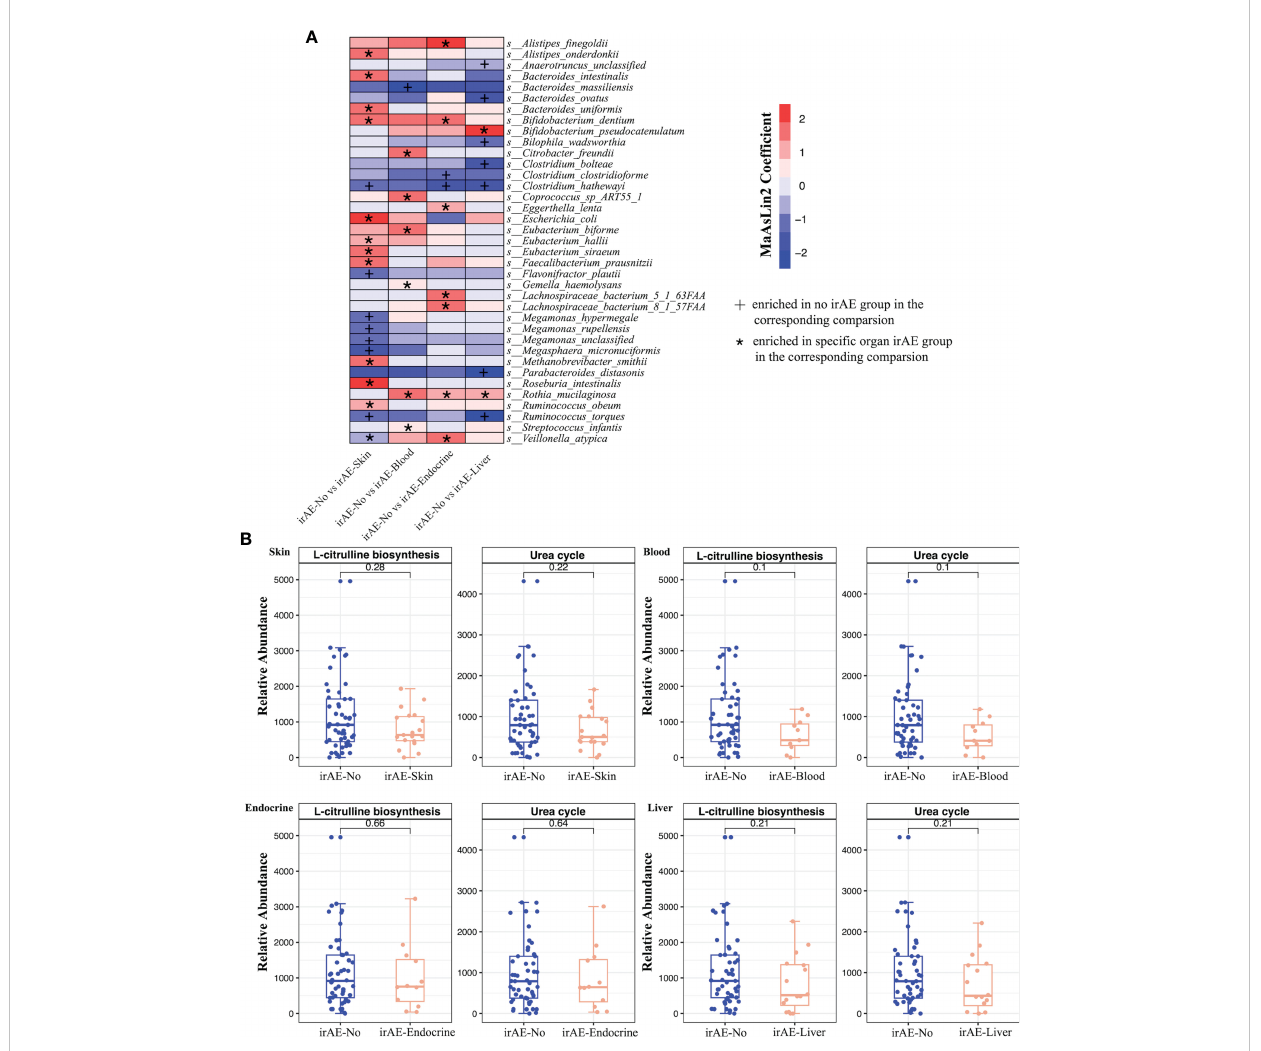
FIGURE 5 (A) Differential species between irAE and non-irAE patients for each comparison group. Each column indicates a comparison for the speci fi c toxicity and the labels (*, +) indicate the direction of enrichment. (B) Boxplots showing the relative abundance of microbial metabolic pathways in irAE patients across different toxicities. Wilcoxon rank sum test was applied, and p values were labeled for each